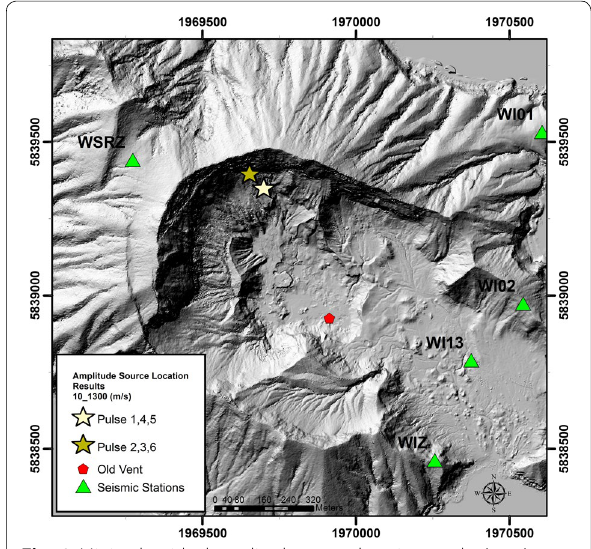
Fig. 6 Minimal residual amplitude source location results (stars) using the base input values of β Q =